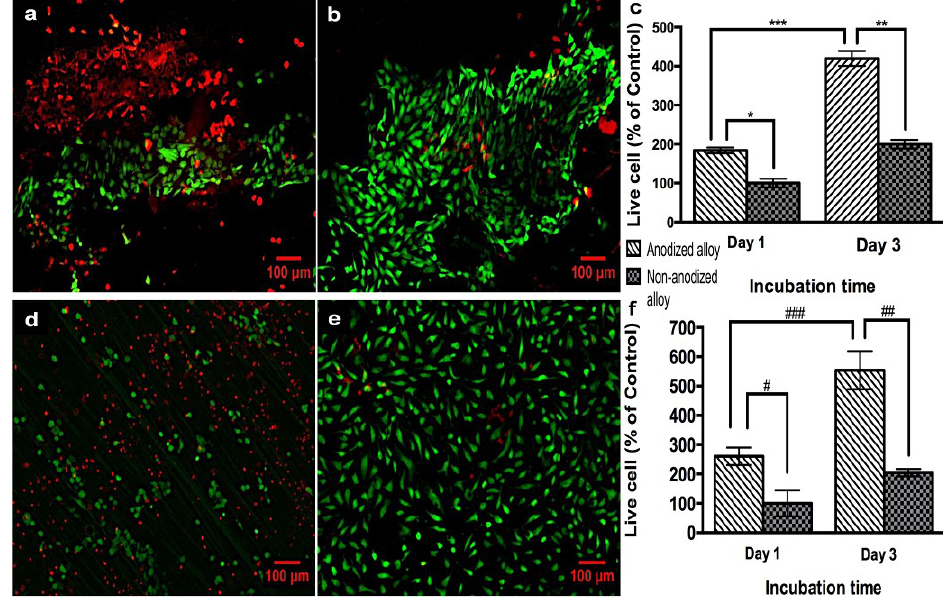
Figure 3. Live/dead staining of pig periosteal osteoblast (PPO) and pig cartilage chondrocytes (PCC) cells on the samples. ( a ) PCC cells on non-anodized Ti6Al4V alloy; ( b ) PCC cells on anodized Ti6Al4V alloy; ( c ) cell counting of live PCC cells; ( d ) PPO on the non-anodized Ti6Al4V alloy; ( e ) PPO on anodized Ti6Al4V alloy; ( f ) cell counting of live PPO cells. (Values are the mean ± SD, n = 3; * p < 0.05 and # p < 0.05, significantly different from non-anodized Ti6Al4V at Day 1 of cell growth; ** p < 0.05 and ## p < 0.05, significantly different from non-anodized Ti6Al4V at Day 3 of cell growth; *** p < 0.05 and ### p < 0.05, significantly different from anodized Ti6Al4V at Day 3. All the images are the same magnification. The bar is 100